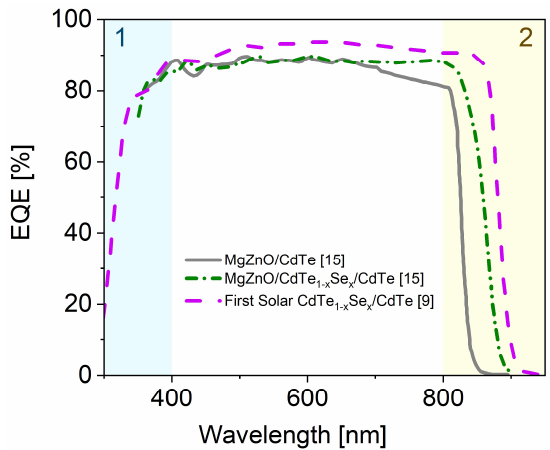
Figure 6. EQE curves of Munshi et al. (adapted from [15]) and the First Solar record device (adapted from [9]).